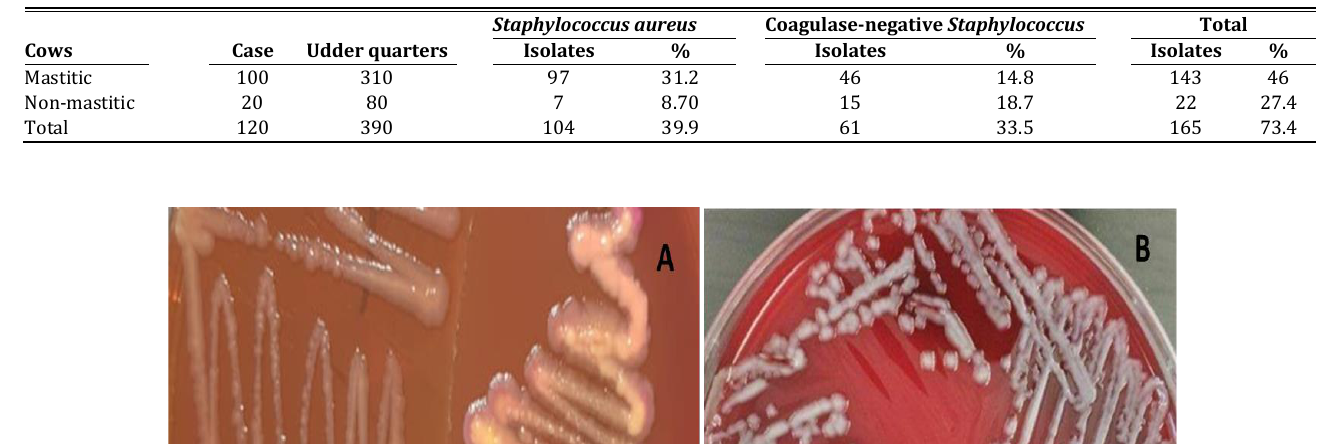
Table 1. Number and percentage of Staphylococcus species isolated from milk of mastitic and non-mastitic cows